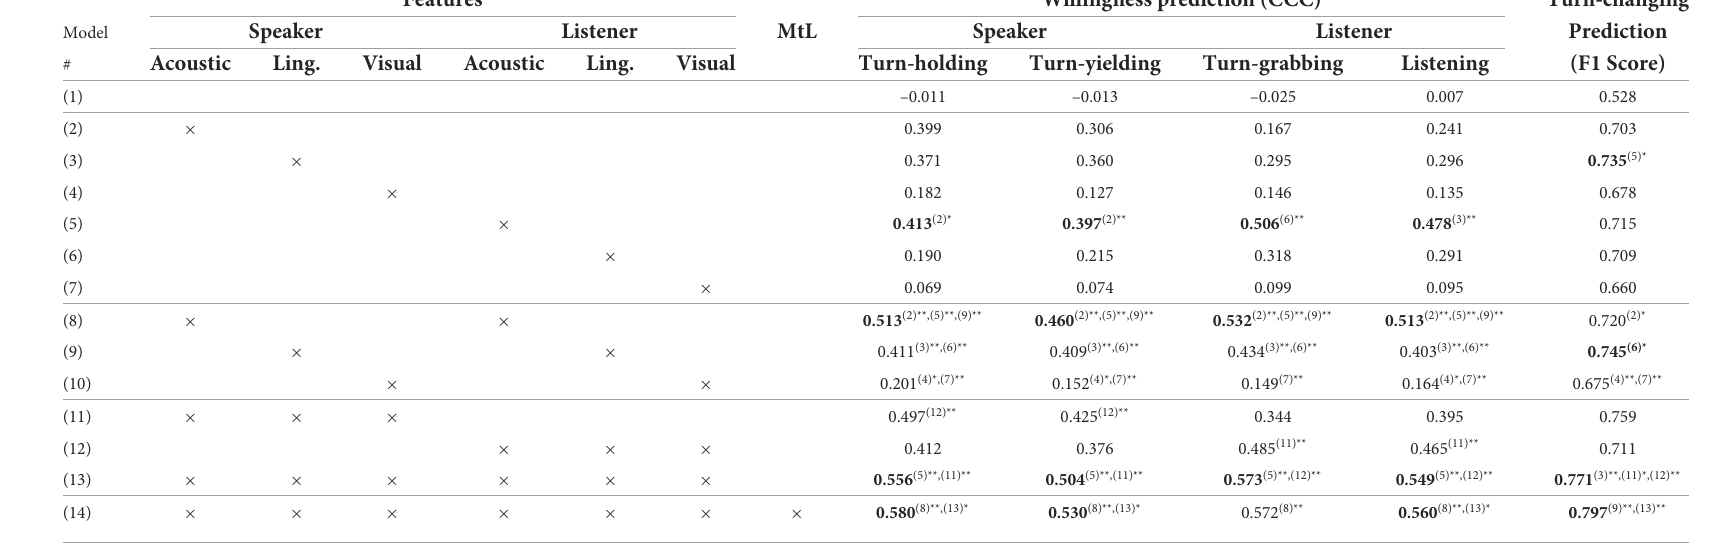
TABLE 1 Results of turn-management willingness and turn-changing